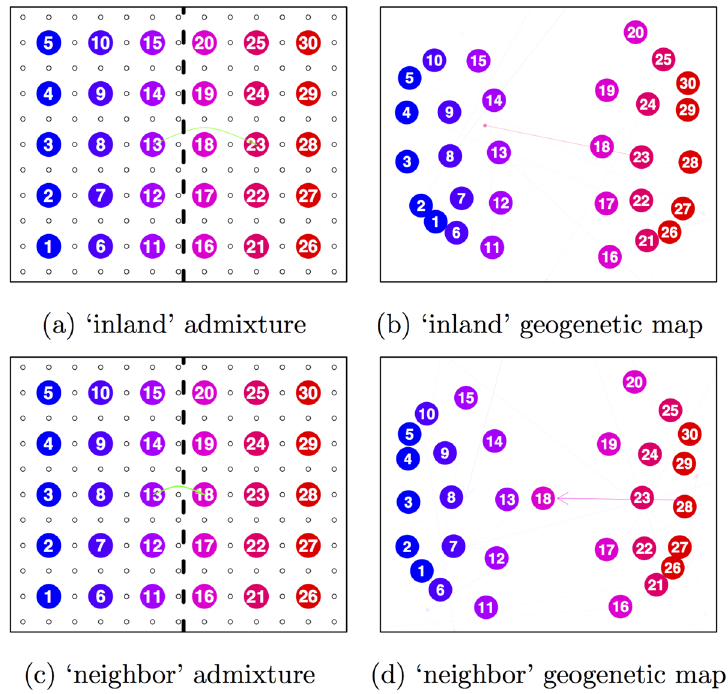
Fig 4. Simulation scenarios and inferred population maps for two different admixture scenarios. Green arrows denote admixture from a source to a target population in the simulation. a) lattice with a barrier and an admixture event (10%) across the barrier to an ‘ inland ’ population; b) the inferred population map for the scenario in (a), where the admixed population 23 is the only population drawing non-negligible admixture (95% CI: 0.02-0.08); c) lattice with a barrier and an admixture event (40%) across the barrier to a ‘ neighbor ’ population on the border of the barrier; (d) the inferred population map for the scenario in (c), where the admixed population 18 is the only population drawing non-negligible admixture (95% CI: 0.04 –